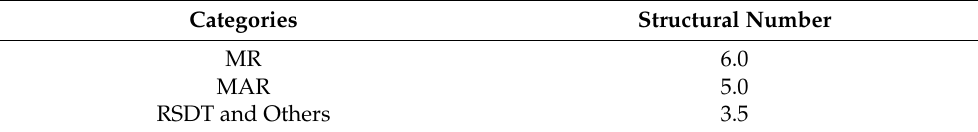
Table 9. Structural number used in RONET